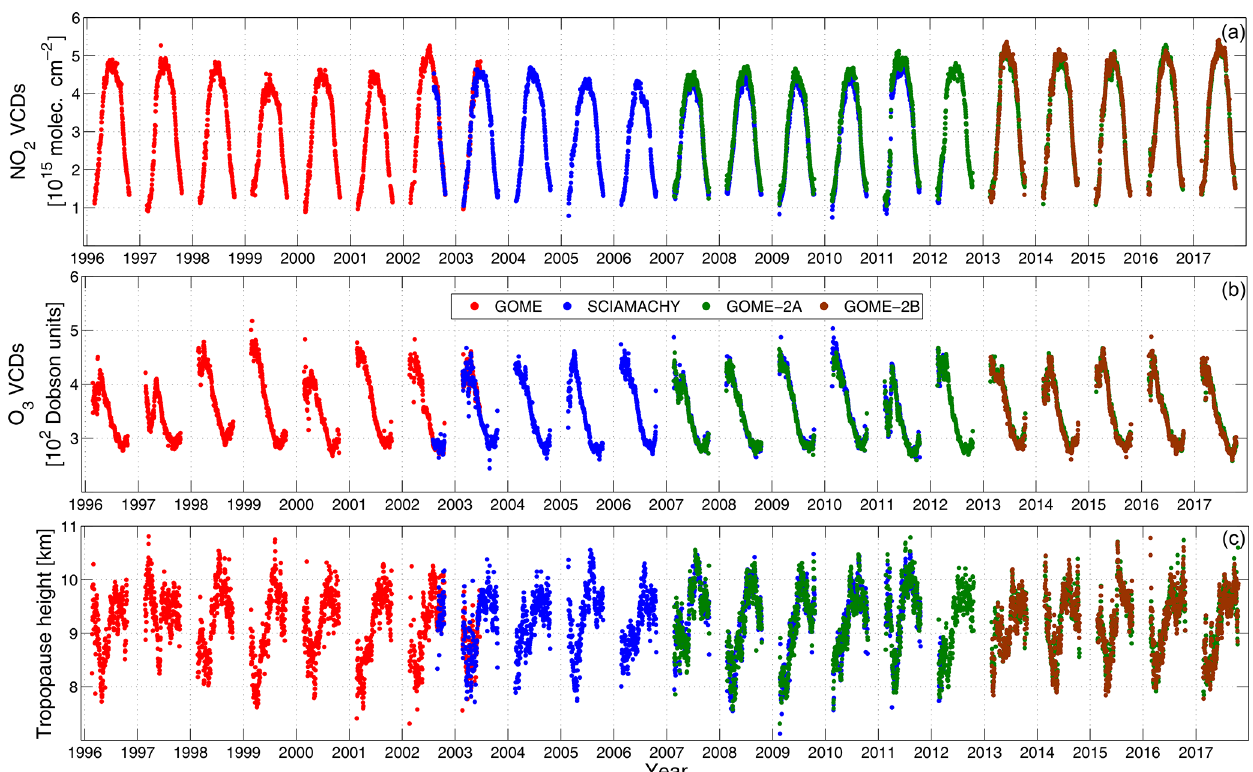
Figure 2. Time series of daily averaged input data over the Arctic used for deriving stratospheric BrO VCDs: (a) stratospheric NO 2 VCDs (moleccm − 2 ) from QA4ECV (GOME, SCIAMACHY and GOME-2A) and TEMIS (GOME-2B), (b) O 3 VCDs (Dobson units) from Weber et al. (2013), and (c) tropopause height (km) from NCEP reanalysis data. Data for the GOME instrument are colored in red, SCIAMACHY in blue, GOME-2A in green and GOME-2B in brown. All three time series show daily averages over the Arctic region ( > 70 ◦ N).